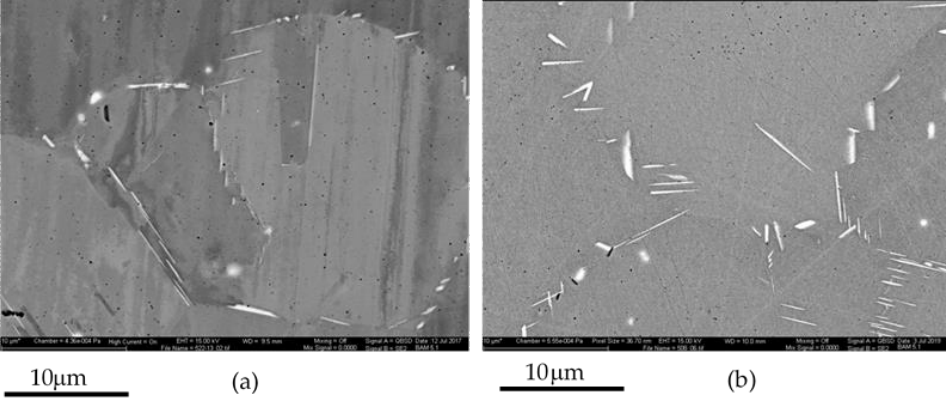
Figure 15. Higher magnification images of Figure 14c,d showing distribution of grain boundary phases for the ( a ) ST + Age and ( b ) FHT specimens. phases for the ( a ) ST + Age and ( b ) FHT